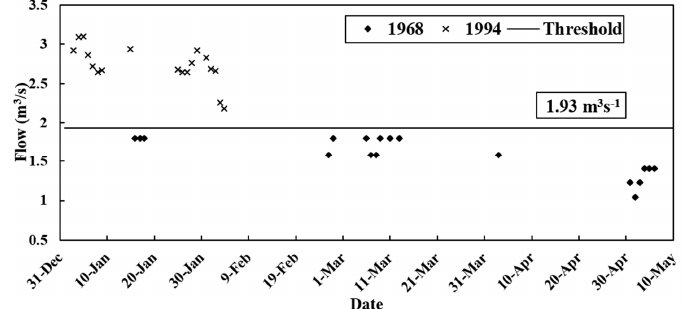
Figure 7. Comparison of the duration of low flows between a reference year (1968) and reforestation year (1994) (please refer to the definition of flow duration in the text for further clarification).